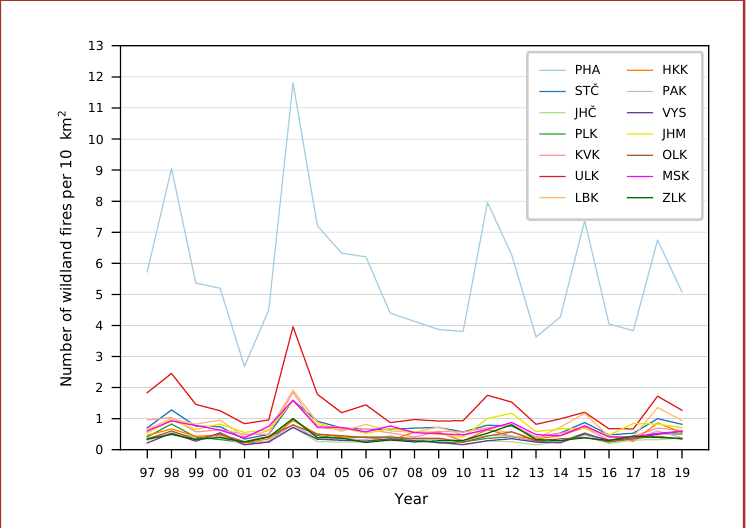
Figure 7. Wildland fires per per 10 km 2 in the 14 regions of the Czech Republic, including the Capital City of